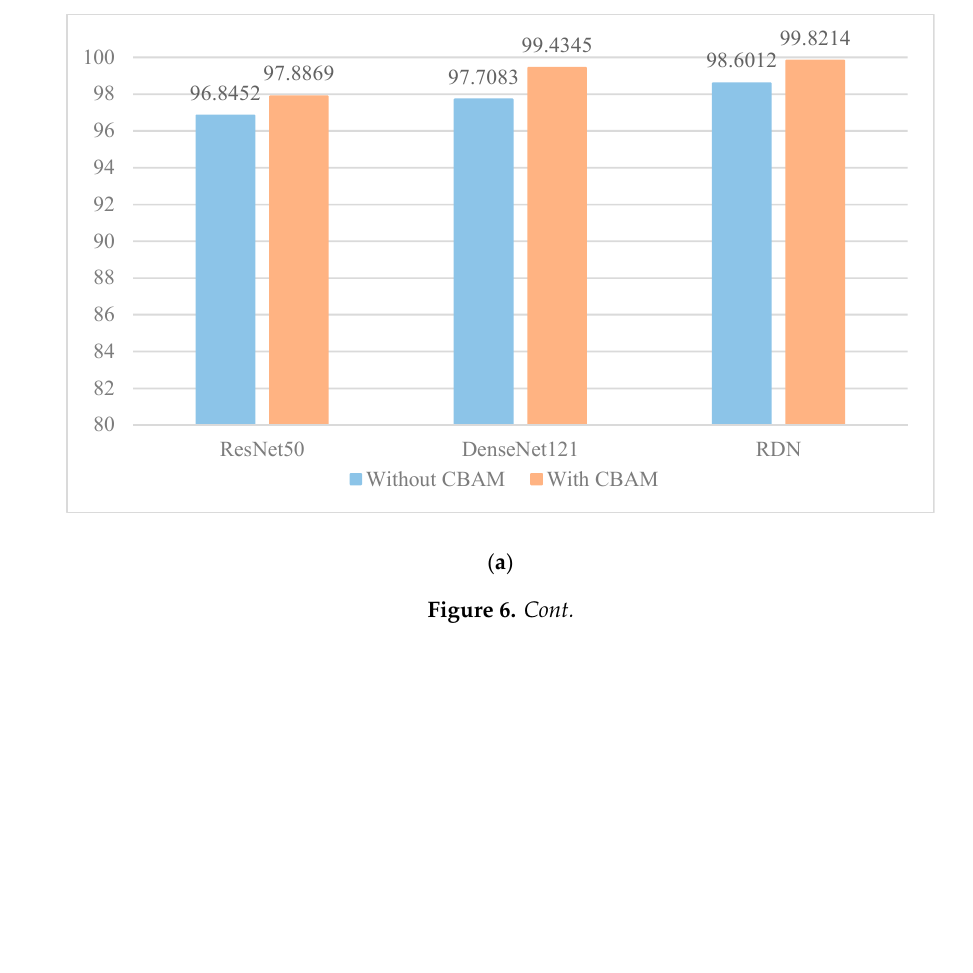
( b ) Figure 6. Overall accuracy of ResNet50, DenseNet121, RDN on UCM and AID datasets with and without CBAM: ( a ) UCM dataset; ( b ) AID dataset. 5.4. Experiment III: Effect of Dataset Augmentation In order to evaluate the impact of the augmented datasets on classification performance, we conduct the original datasets and the augmented datasets for UCM and AID on the proposed RDN + CBAM. The experimental result is shown in Figure 7. After the augmentation strategy, the overall accuracy of scene classification is increased by 9.4196% and 12.1765% on UCM and AID, respectively. It is illustrated that the amount of augmented data is large enough to meet the training requirements of network parameters and can make the network learn rotation robust features. Therefore, it is necessary to conduct an augmentation strategy if there is not a pre-trained classification model.